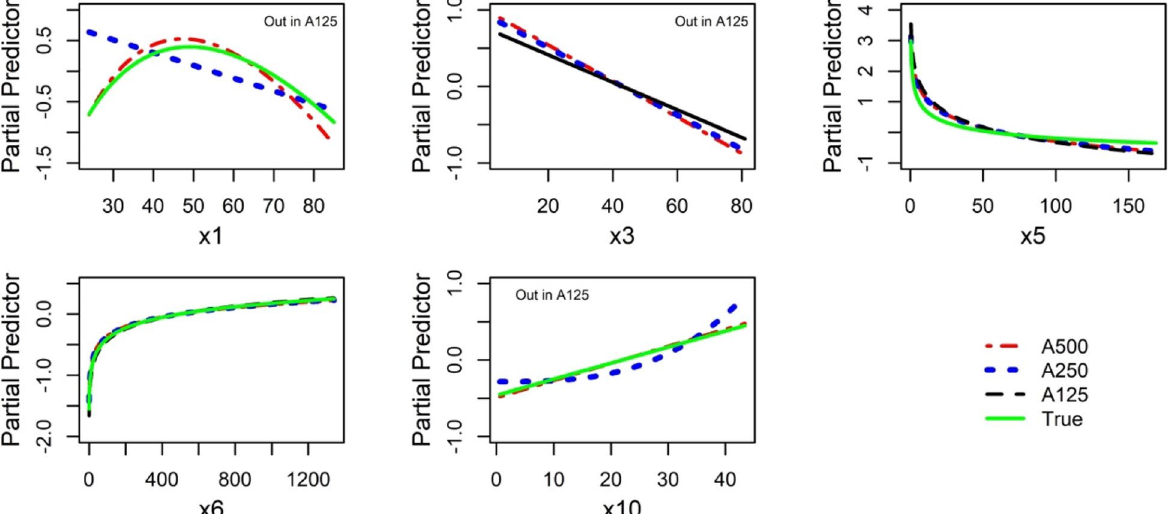
Fig. 7 Data A125, A250, and A500. Functional forms of continuous variables after elimination of IPs identified in multivariable model (results of IPAm in Table 4). Variables x1, x3, and x10 were not selected in